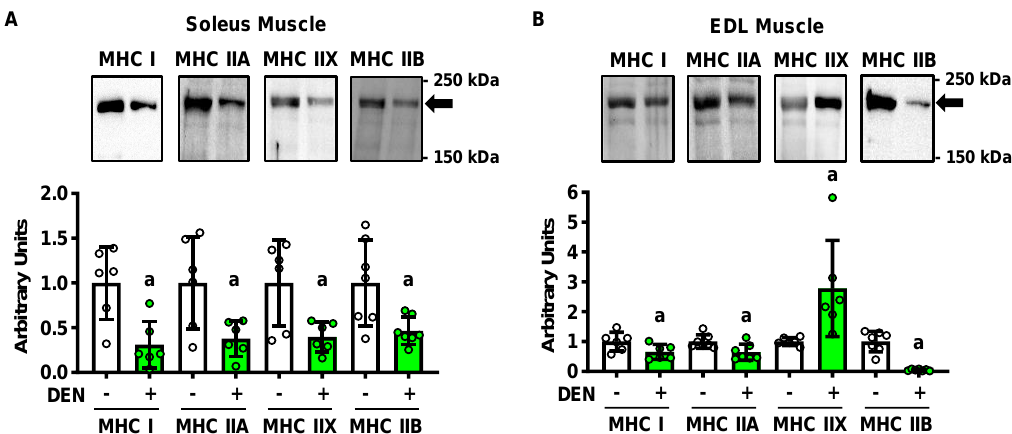
Figure 2. Long-term denervation (DEN) differentially alters myosin heavy chain (MHC) isoform protein levels between the soleus and extensor digitorum longus (EDL) muscles. In male wild-type mice, hindlimb muscle DEN was induced in one leg for 28 days while the contralateral leg was sham-operated (-). Muscles were excised and MHC isoform content assessed by immunoblot in the ( A ) soleus and ( B ) EDL muscles. Statistical significance was defined as p < 0.05, assessed by paired t-tests, and denoted by ‘a’ vs. -. n = 6–7 muscles/group.